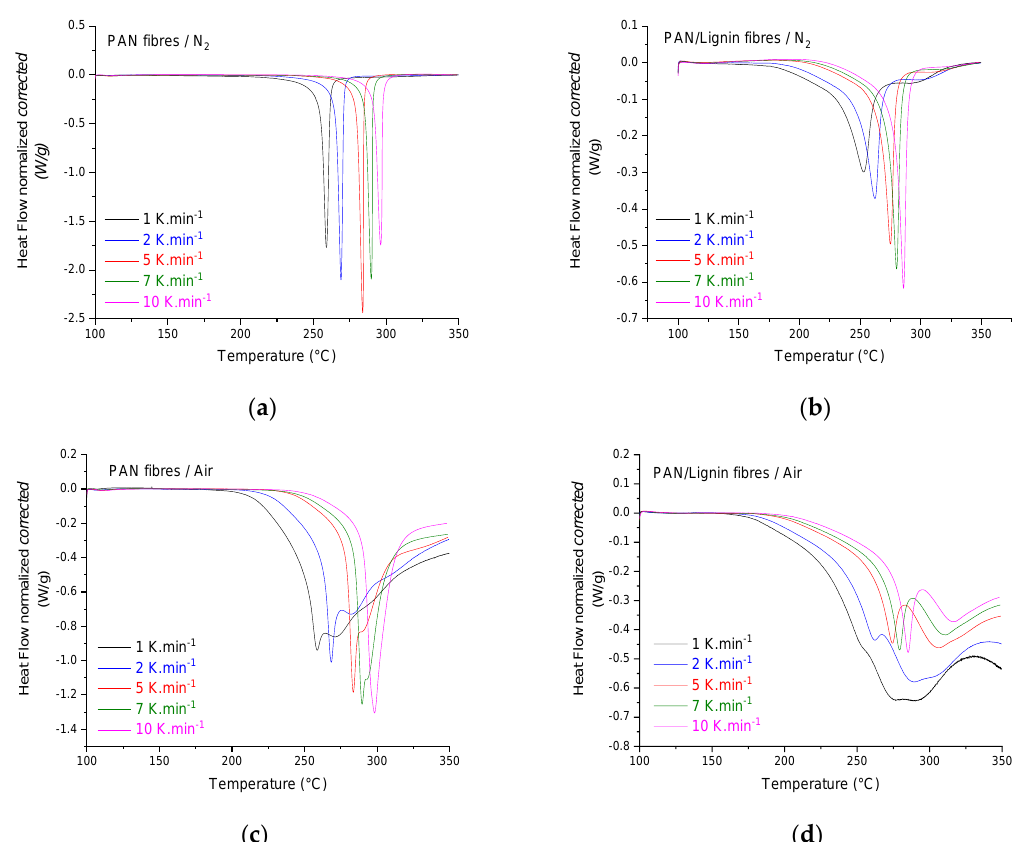
Figure 10. Differential scanning calorimetry (DSC) measurements at different heating rates for ( a ) Figure 10. Di ff erential scanning calorimetry (DSC) measurements at di ff erent heating rates for ( a ) PAN PAN fibers under nitrogen; ( b ) PAN/lignin fibers under nitrogen; ( c ) PAN fibers under air; and ( d ) fibers under nitrogen; ( b ) PAN / lignin fibers under nitrogen; ( c ) PAN fibers under air; and ( d ) PAN / lignin PAN/lignin fibers under air. fibers under